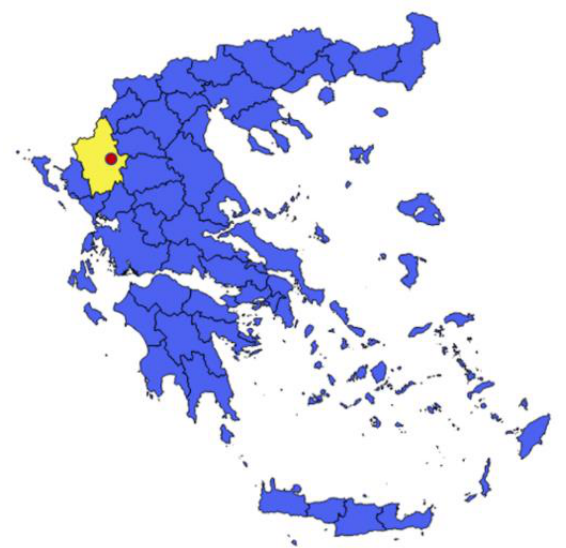
Figure 1: Metsovo village (red), Epirus region (yellow) (geodata.gov.gr, 2018)